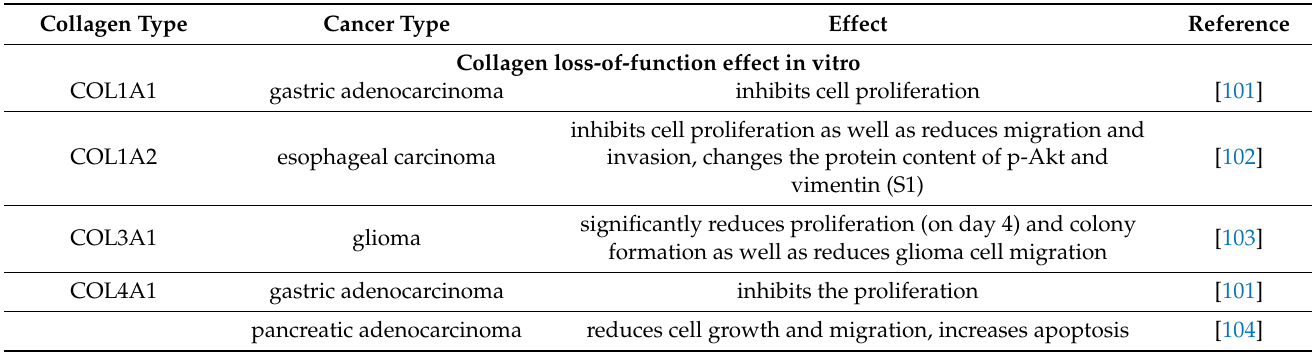
Table 1. In vitro studies focused on collagen